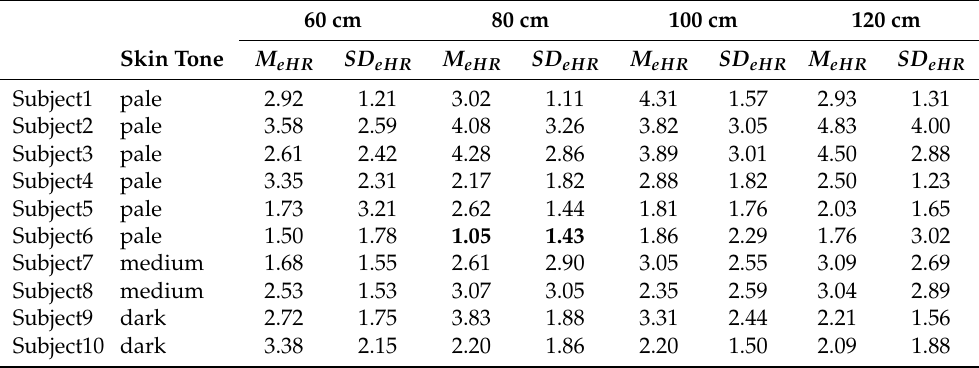
Table 3. Mean and standard deviation of the absolute error between the estimated HR and the reference HR (unit: beats/min). Boldface character denotes the best